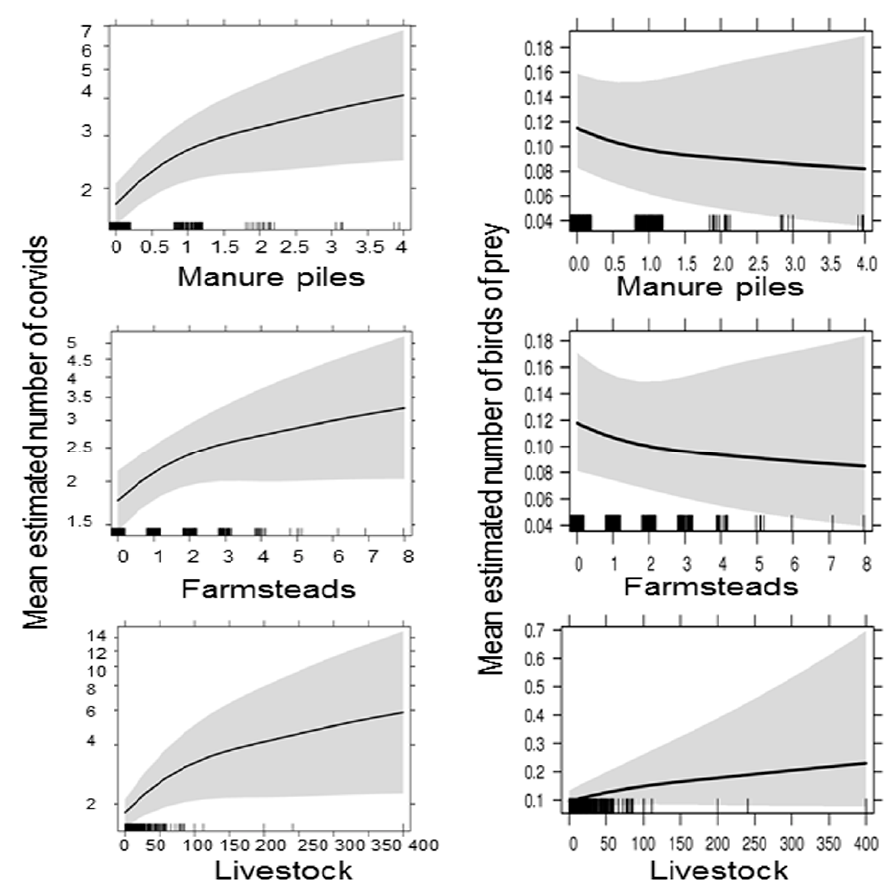
Figure 4. The mixed-effects generalized linear model predictions for corvid birds (left) and raptors (right) and their relationships with three proxy variables of resource density in terms of manure piles (top), farmsteads (middle) and livestock (bottom). The black line indicates the mean predicted value, the shaded areas represent 95% confidence intervals and the black tick on the horizontal axis are the raw data. Note that for raptors, none of the relationships were significant.